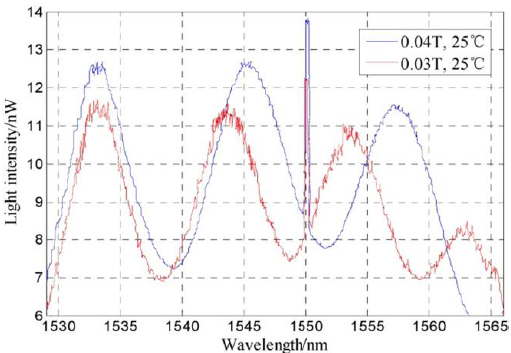
Figure 13. Optical reflection spectra of the FPI-FBG based sensor under two magnetic fields. Reproduced from [52].